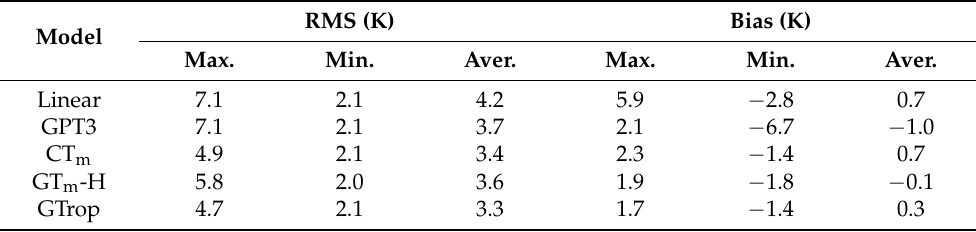
Table 2. Average RMS and Bias of the five T m models at 87 RS stations over the period of 2011 to 2020. RMS (K) Bias (K) Model Max. Min.